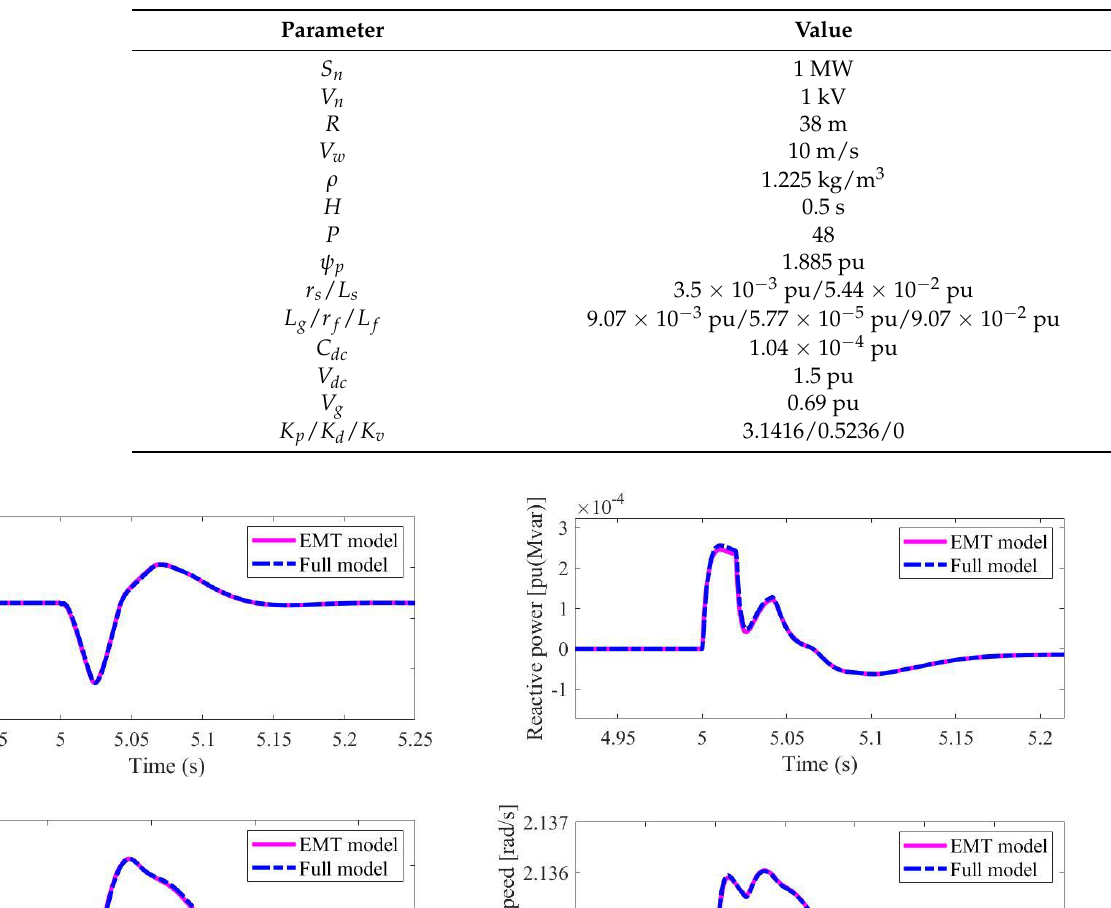
Table 1. D-PMSG parameters and settings.